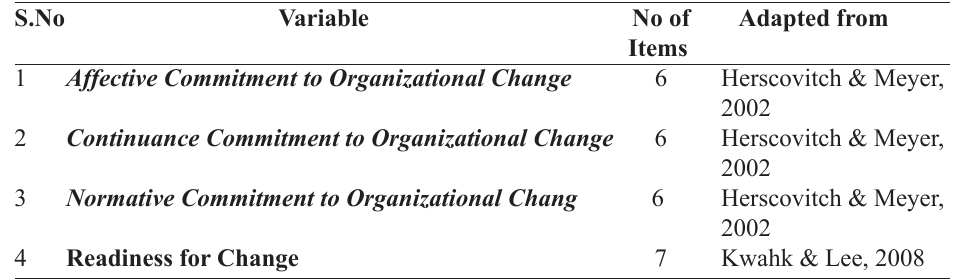
Table 2 : Variables and